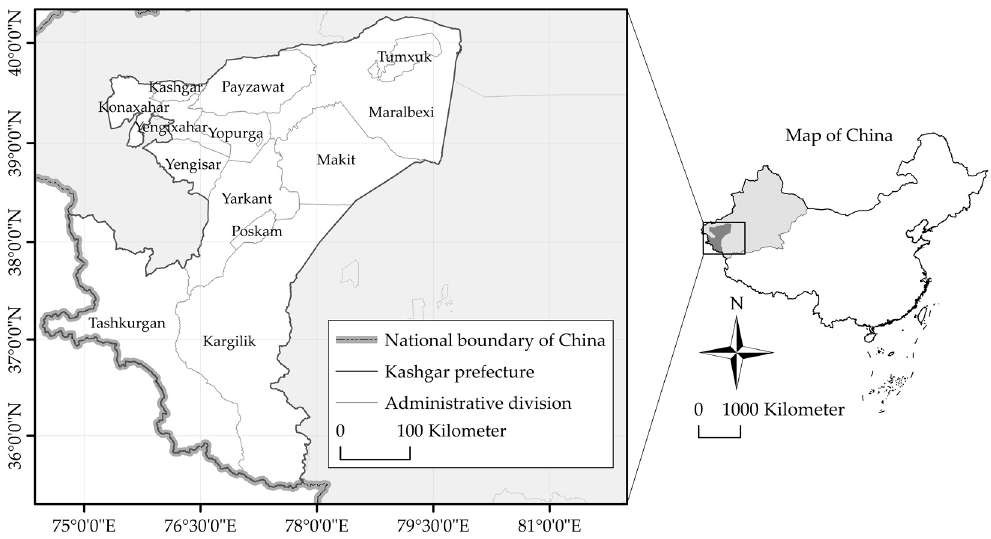
Figure 1. Schematic diagram of the Kashgar region division.